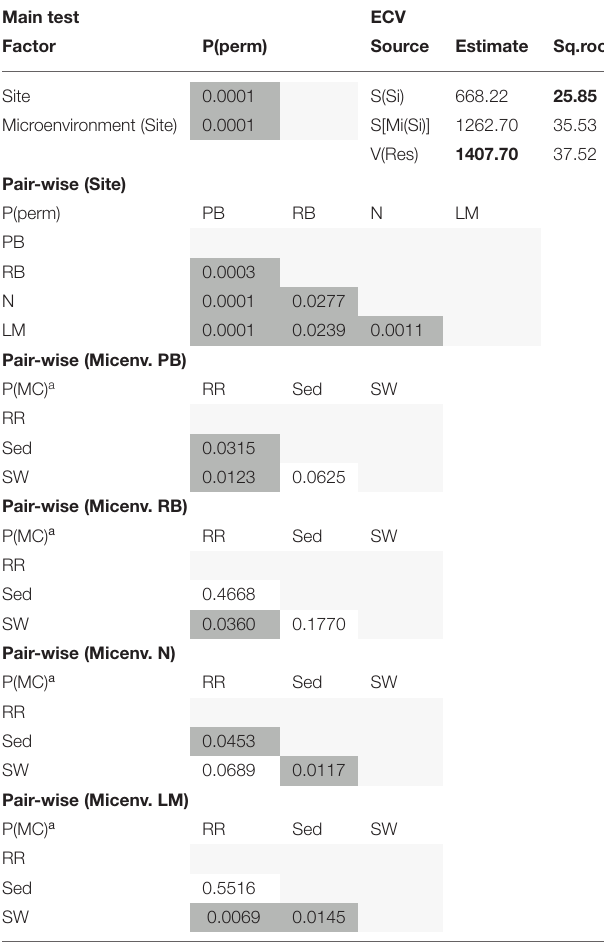
SUPPLEMENTARY TABLE 8 | Statistical analyses for multidimensional scaling (Fungi).